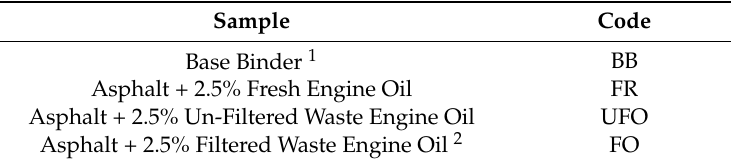
Table 4. Experimental samples and respective